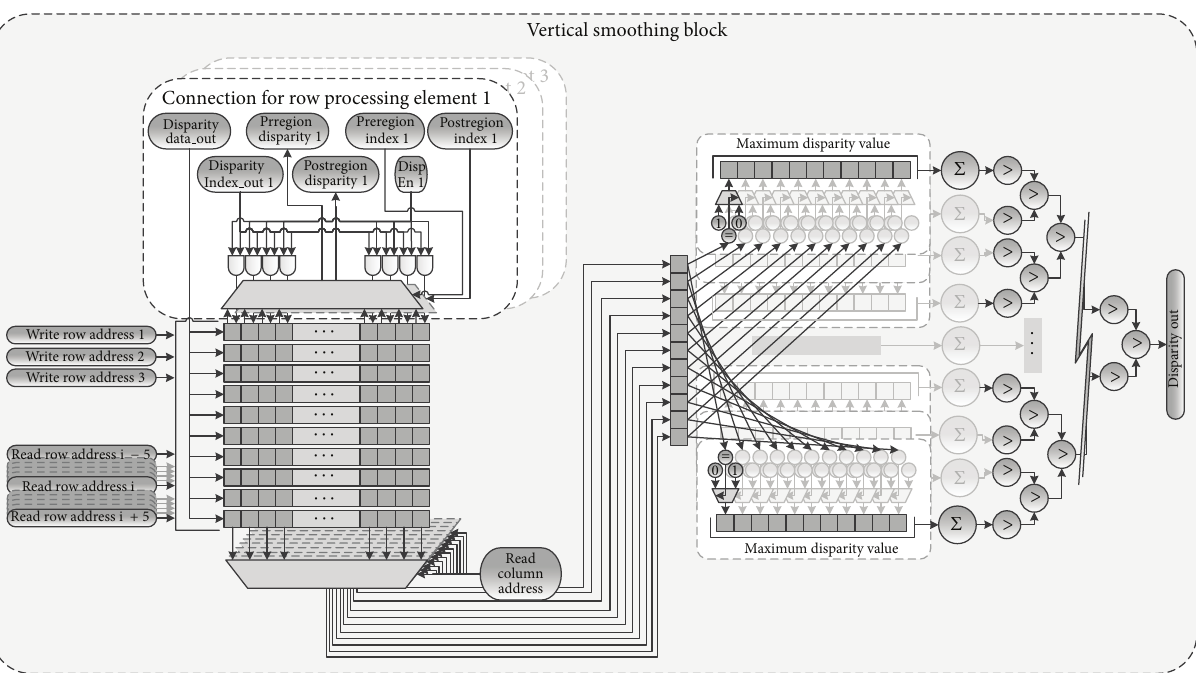
Figure 8: Vertical smoothing hardware block diagram.